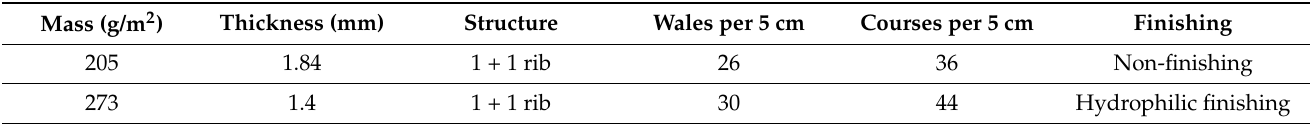
Table 1. The knitted fabric parameter (treated fabric had higher mass, lower thickness, and higher loop density due to the shrinkage of